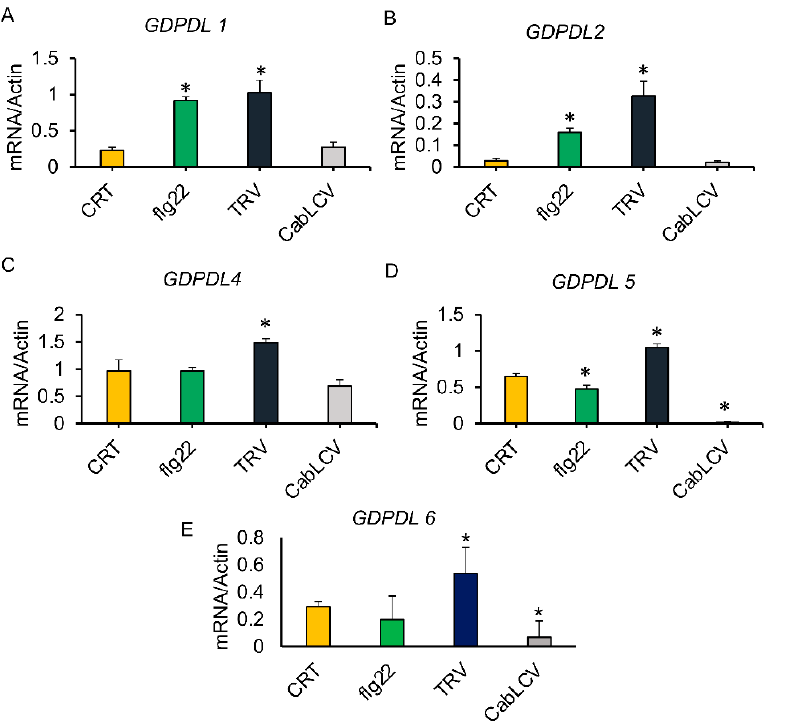
Figure 5. Expression analysis of the GDPDL genes in response to biotic signals. For the flg22-induced expression of GDPDLs (as indicated in the figure), 12-day-old Arabidopsis seedlings were treated with 100 nM flg22, and total RNA was prepared from 100 µg of a pool of 10 flg22-treated plants. For TRV infection, Arabidopsis leaves were mechanically inoculated with TRV from N. benthamiana -infected leaves, and TRV infection was diagnosed by PCR. For CabLCV infection, Arabidopsis plants were inoculated with infectious DNA-A and DNA-B clones, and viral accumulation was monitored by PCR. After 15 days of TRV inoculation and 21 days of CabLCV inoculation, total RNA was extracted from a pool of 10 TRV- and CabLCV-infected plants. The transcript accumulation of the indicated genes was monitored by quantitative RT-PCR with gene-specific primers. The gene expression was calculated by the 2 − ∆ CT method using actin as an endogenous control. The error or standard bars indicate the mean ± SD ( n = 3, technical replicates). * p < 0.05.